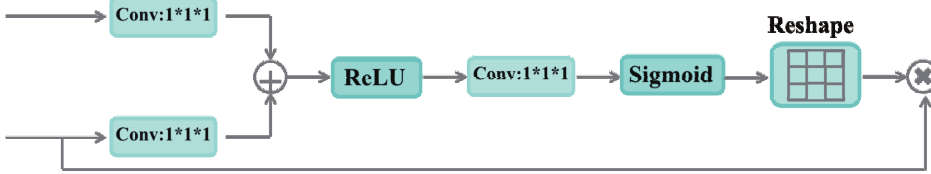
Figure 1. The architecture of FACNN.